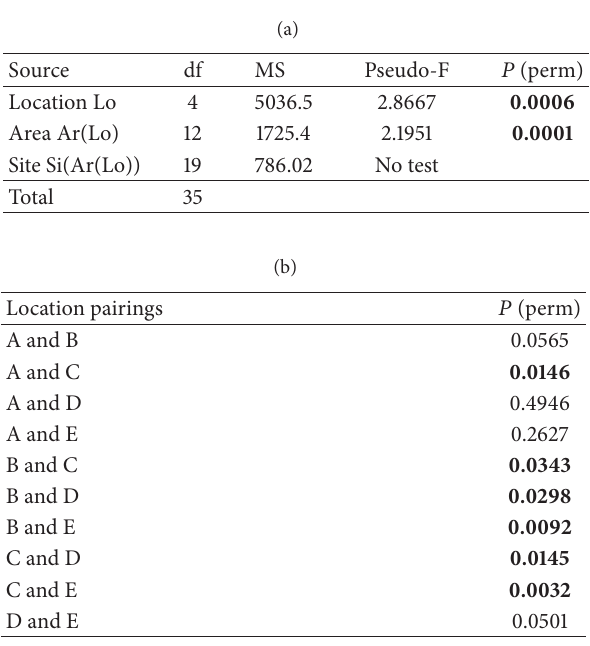
Table 2: (a) PERMANOVA to compare the infrequent/conspicuous species assemblage based on Bray Curtis similarities. Data were dispersion weighted and square root transformed. (b) Pairwise tests for Location. 𝑃 values in bold type are significant.